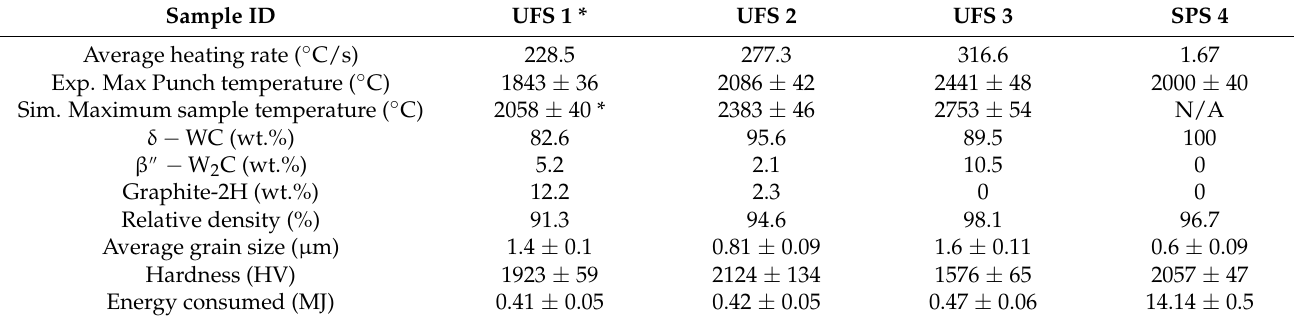
Figure 6. X-ray Diffraction (XRD) patterns of sample UFS 1, sample UFS 2, sample UFS 3 and sample SPS 4. Table 2. Summary of processing conditions and properties of the samples prepared using SPS and UFS.